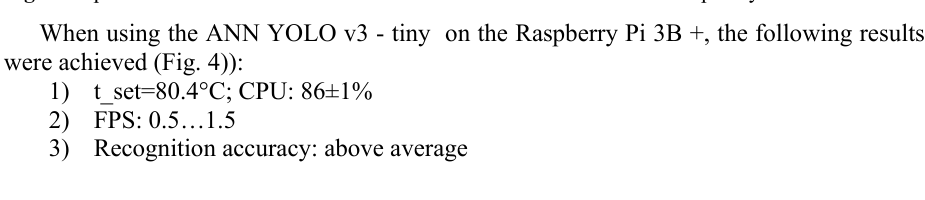
Fig. 3. Experimental verification of the MobileNet neural network on the Raspberry Pi 3B